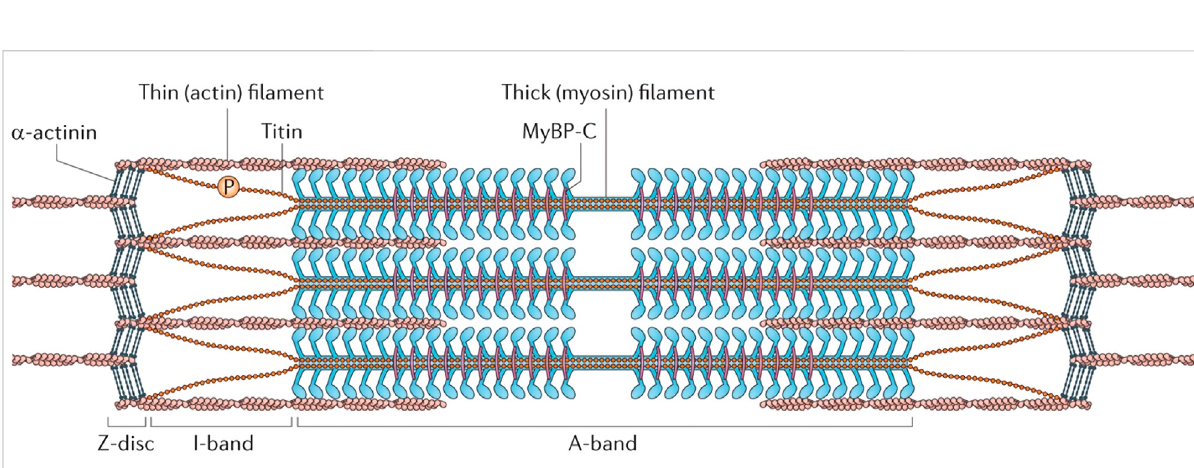
protein and F-actin, it should be researched further to better comprehend the muscle contraction. Advances in single- molecule experiments have revealed precise knowledge about myosin architectures (Ferrer et al., 2008; Sweeney and Houdusse,